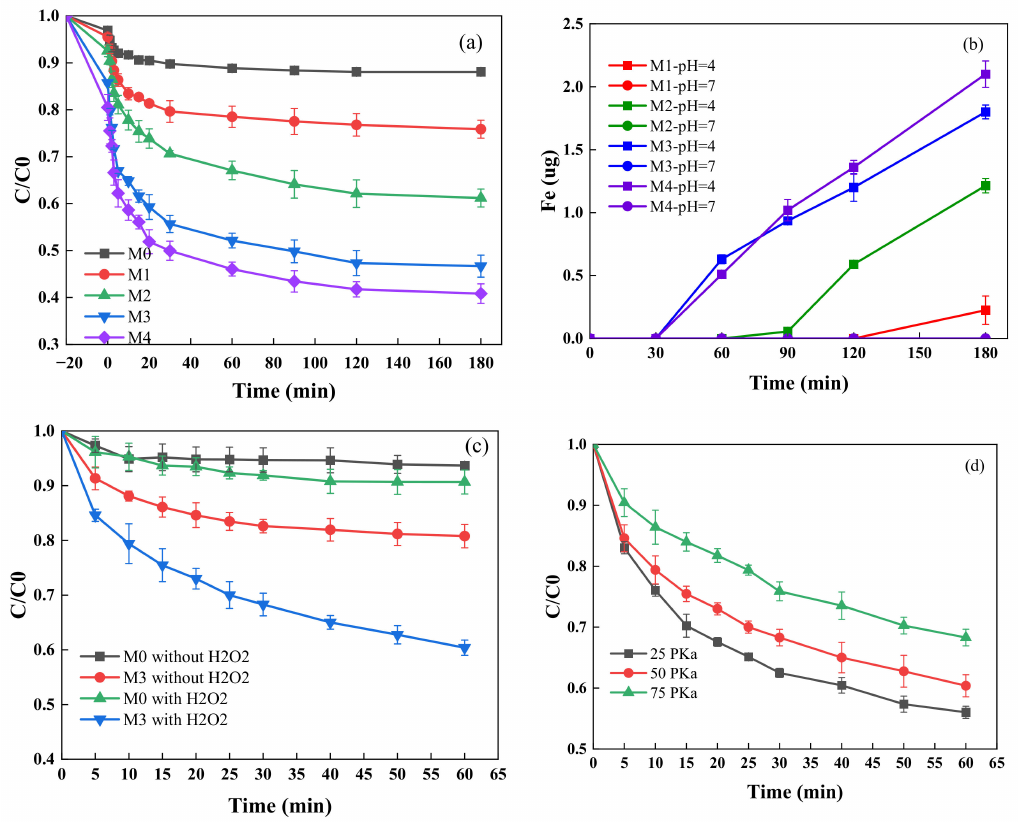
Figure 5. ( a ) Catalytic degradation effect of MB at pH = 4; ( b ) Fe release from the MoS 2 -FeOOH/PES membranes at different pH; ( c ) degradation effect of MB in cross-flow filtration at 50 KPa; ( d ) degra- dation effect of MB in cross-flow filtration at 25, 50, and 75